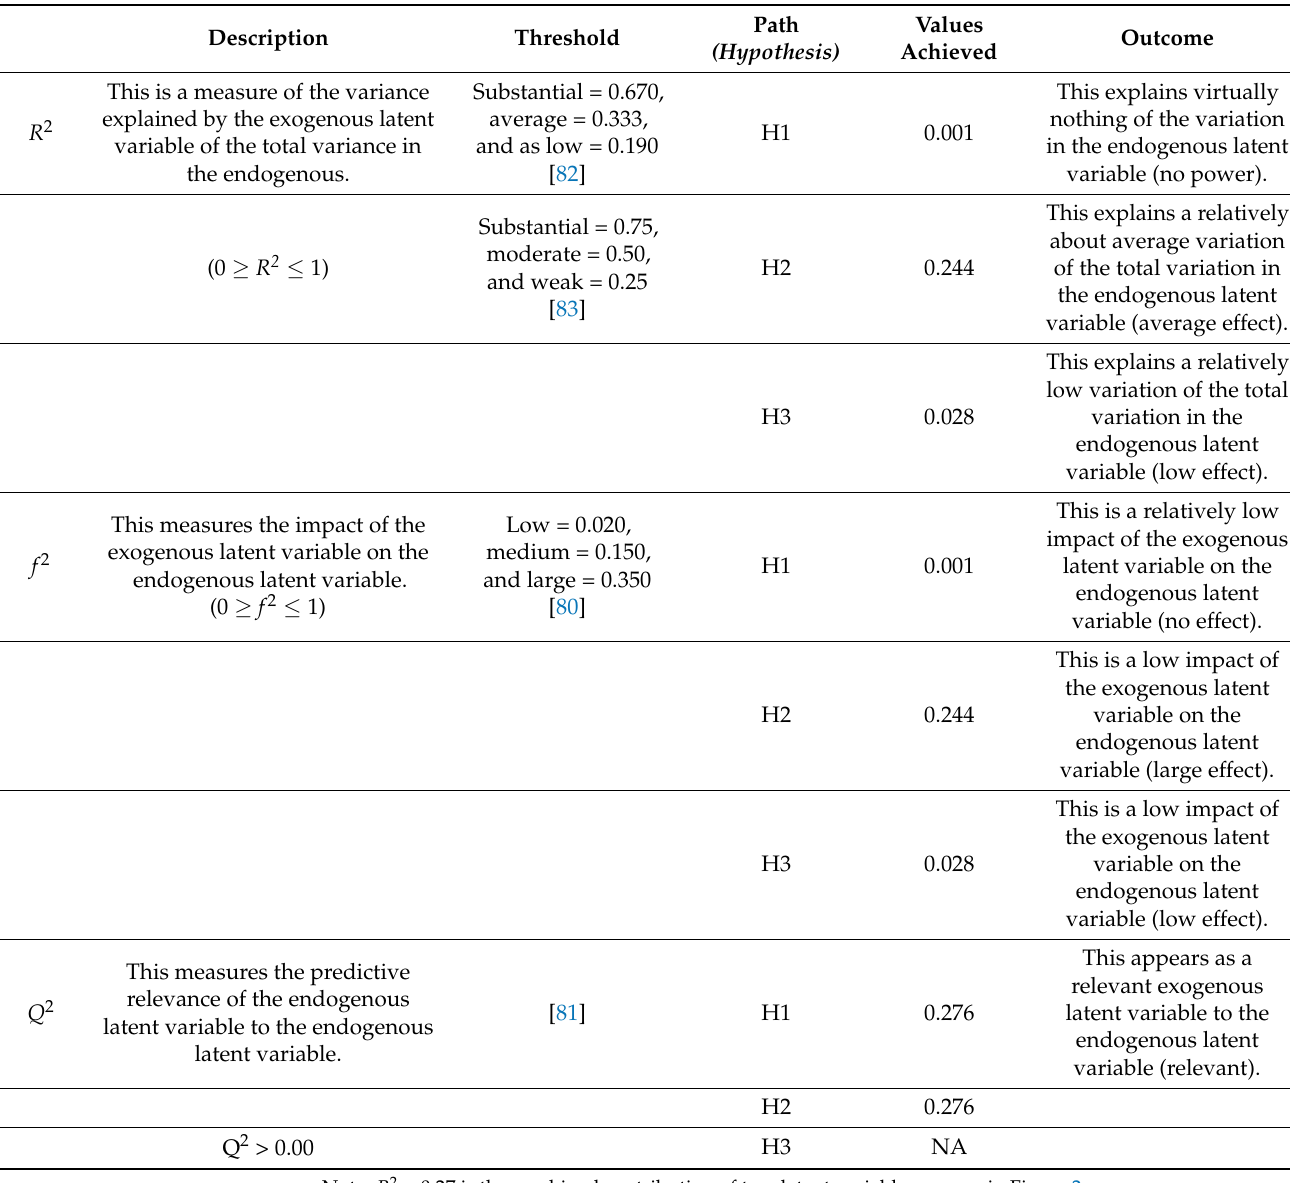
Table 4. Structural model validation. Source: Author data.